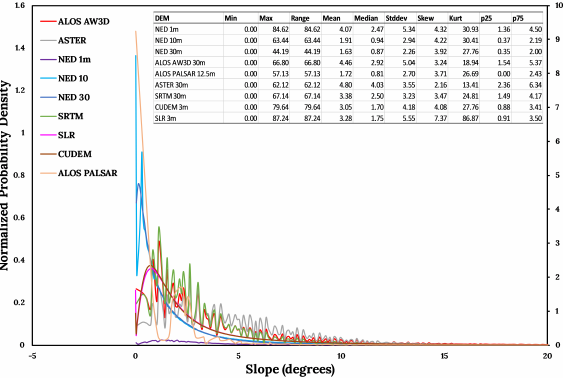
Figure 5. The distribution of slope values for all considered datasets with histogram curves and statistical matrices table The slope histograms of ALOS AW3D, ASTER, and SRTM DEMs slightly shifted to the right and showed a more signific- ant number of steeper slopes. Overall, all DEMs showed the same tendency towards slope identification in New York